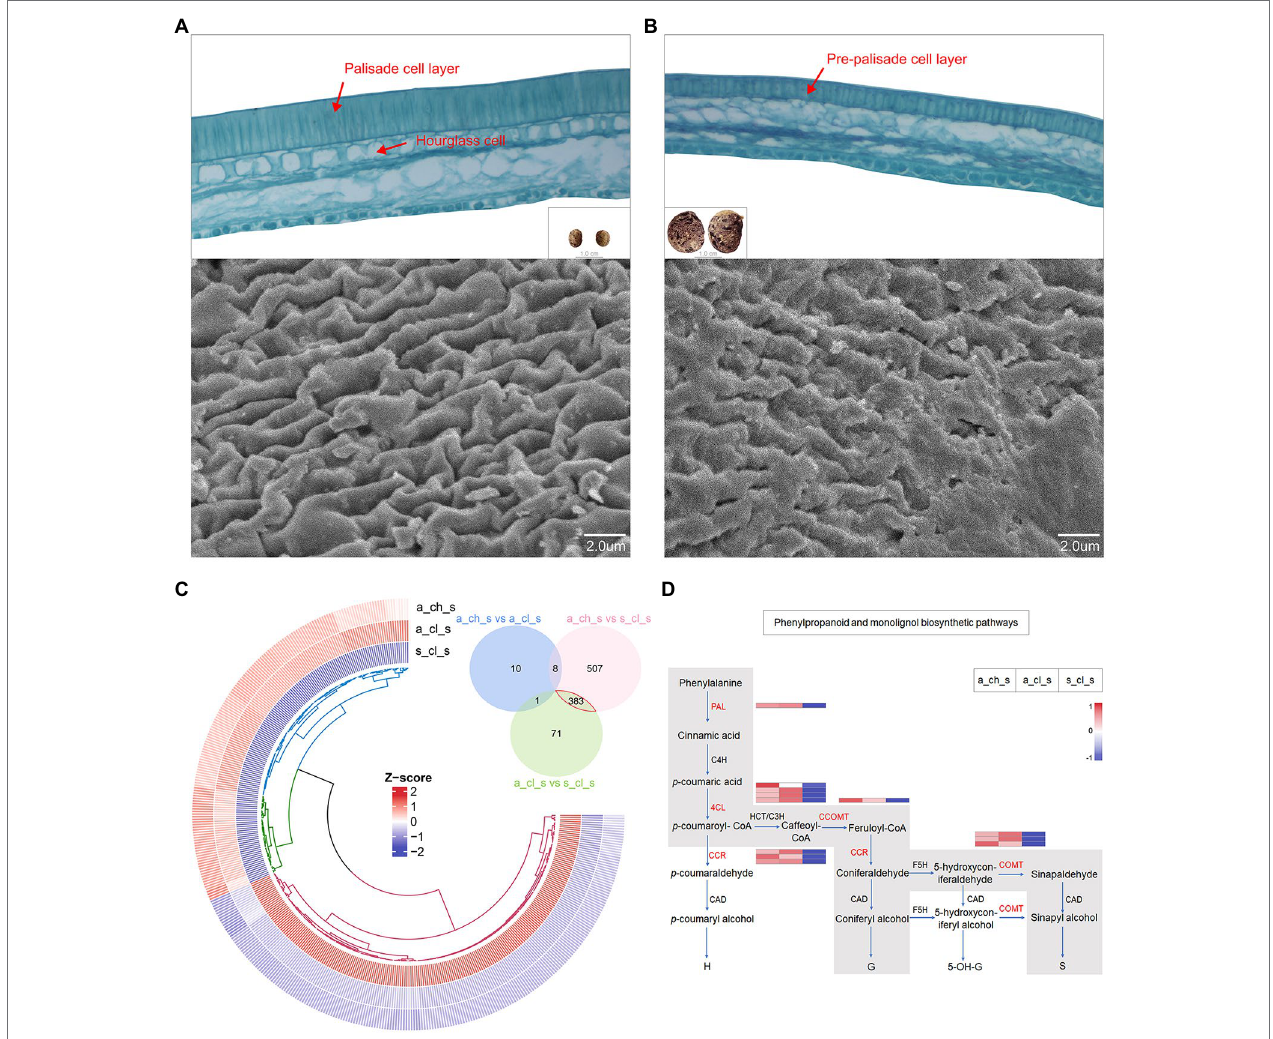
FIGURE 6 | Seed micromorphology and its transcriptome profiling. (A) Paraffin section images of an aerial seed and scanning electron microscopy (SEM) details of the testa surface. (B) Paraffin section images of a subterranean seed and SEM details of the testa surface. (C) Venn plot and circular heatmap between aerial (A_ CH_S and A_CL_S) and subterranean seeds (S_CL_S). (D) Biosynthetic pathways of phenylpropanoid and monolignol. The gray box indicates the phenylpropanoid and monolignol biosynthetic pathways that are generally accepted for angiosperms with indication of the expression levels of the 5 key genes (in red) in this study by